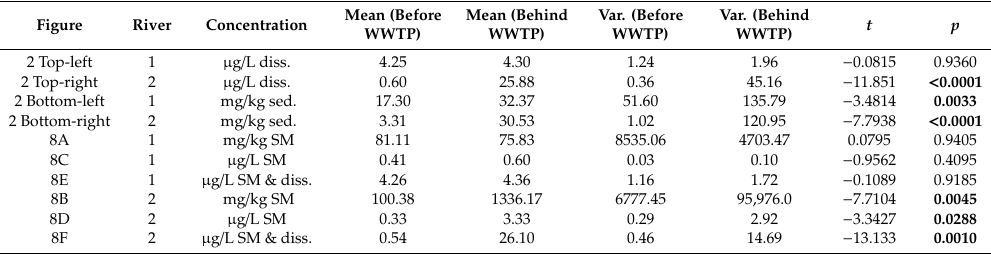
Table A2. Statistical analysis regarding the change of total phosphonate content between before and behind the WWTP (two-tailed t -test; null-hypothesis: no di ff erence between two samples; α = 0.05). Figure